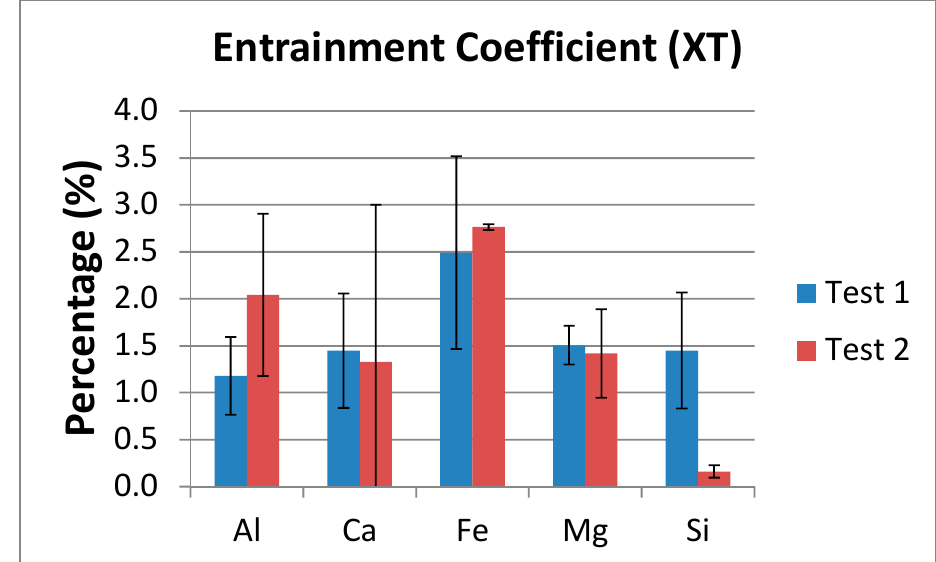
Figure 3. Total entrainment coefficients ( XT ) calculated on mass percentage of Al, Ca, Fe, Mg and Si measured in the fly ashes of the power plant by means of the main stages and streams involved.